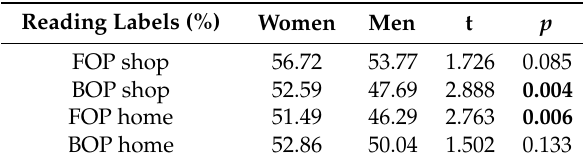
Table 1. Reading food labels by sex.